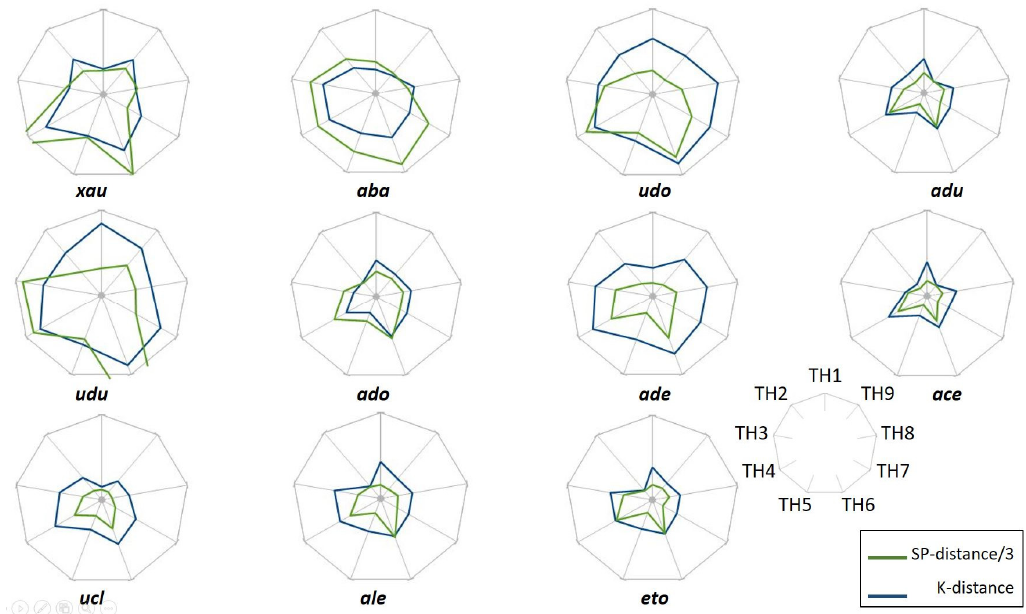
Figure 12. SP-distances/0.28 and K-distances between the guests and the TOPIC HUBS ; the maximum on each axis is 0.5.